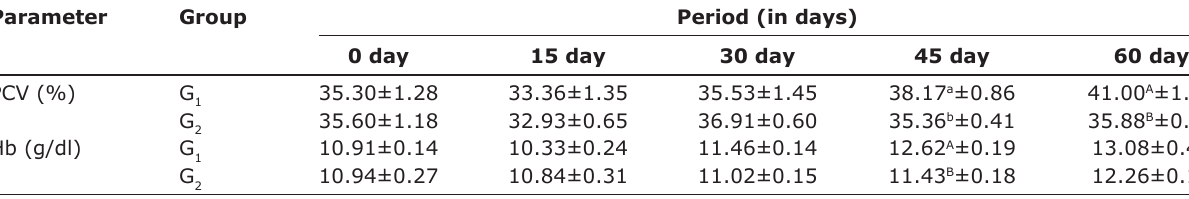
Table-2: Mean±SE of hematological parameters of Vrindavani calves at fortnightly interval. Parameter Group